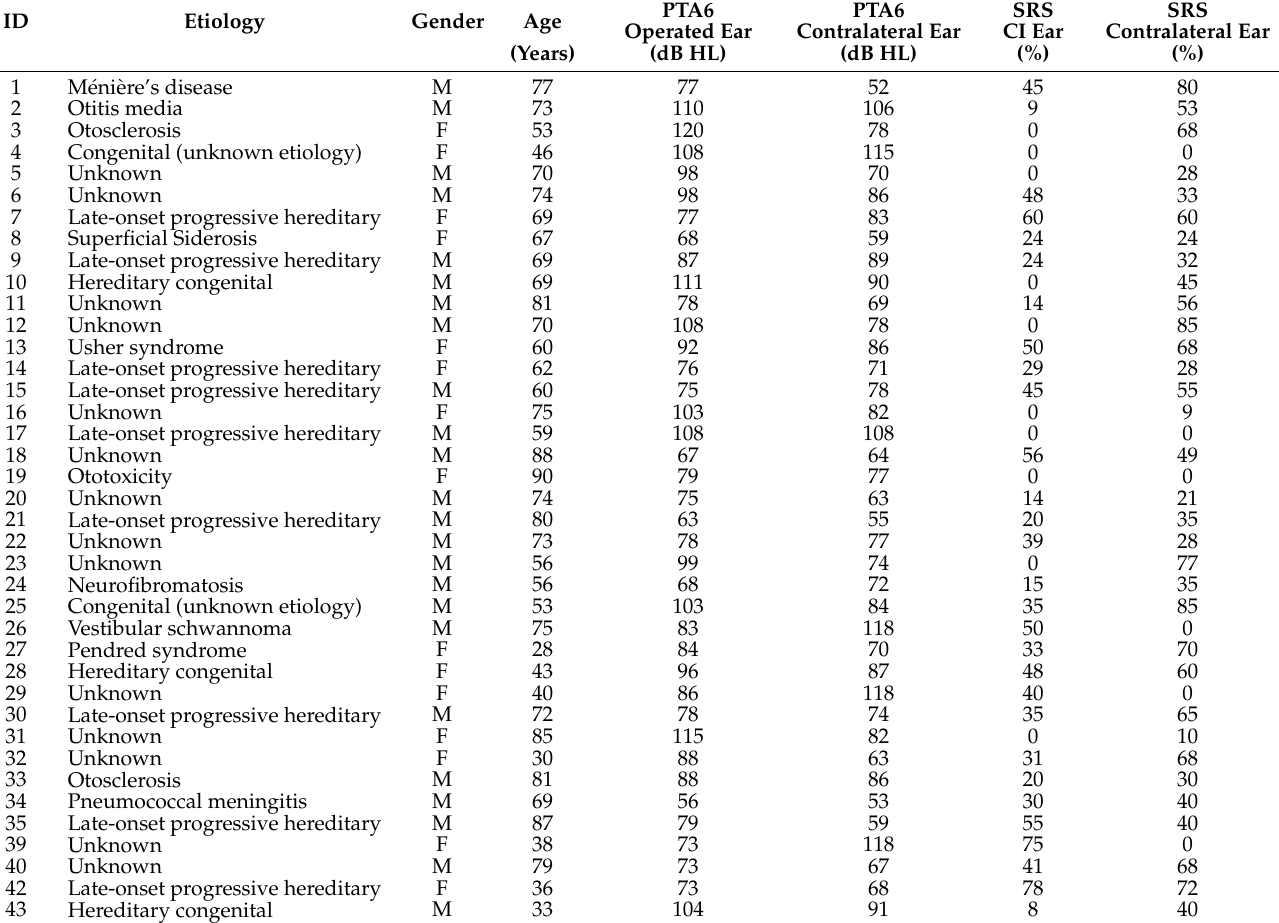
Table 2. The baseline info on hearing loss etiology and pre-operative hearing for the 39